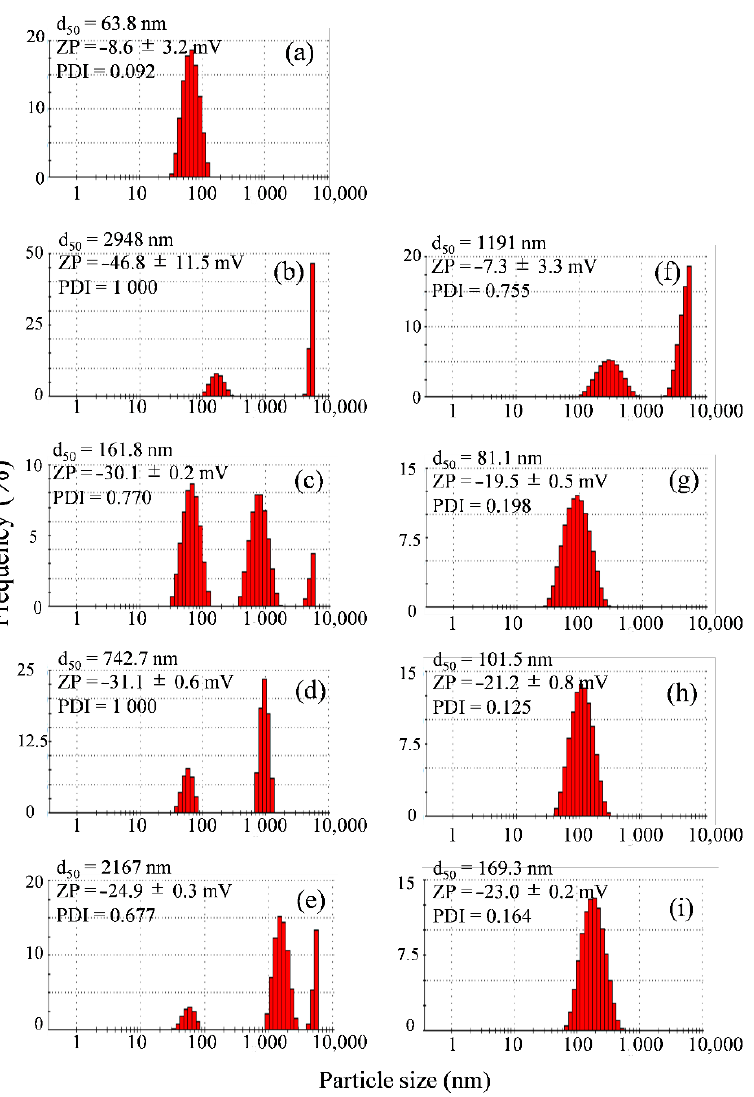
Figure 2. Particle size patterns and zeta potential of ( a ) Sol, ( b ) ASC-P, ( c ) Sol/ASC-P (9/1), ( d ) Sol/ASC-P (8/2), ( e ) Sol/ASC-P (7/3), ( f ) ASC-DP, ( g ) Sol/ASC-DP (9/1), ( h ) Sol/ASC-DP (8/2), and ( i ) Sol/ASC-DP (7/3). Zeta potential represents the mean ± S.D. ( n = 3).